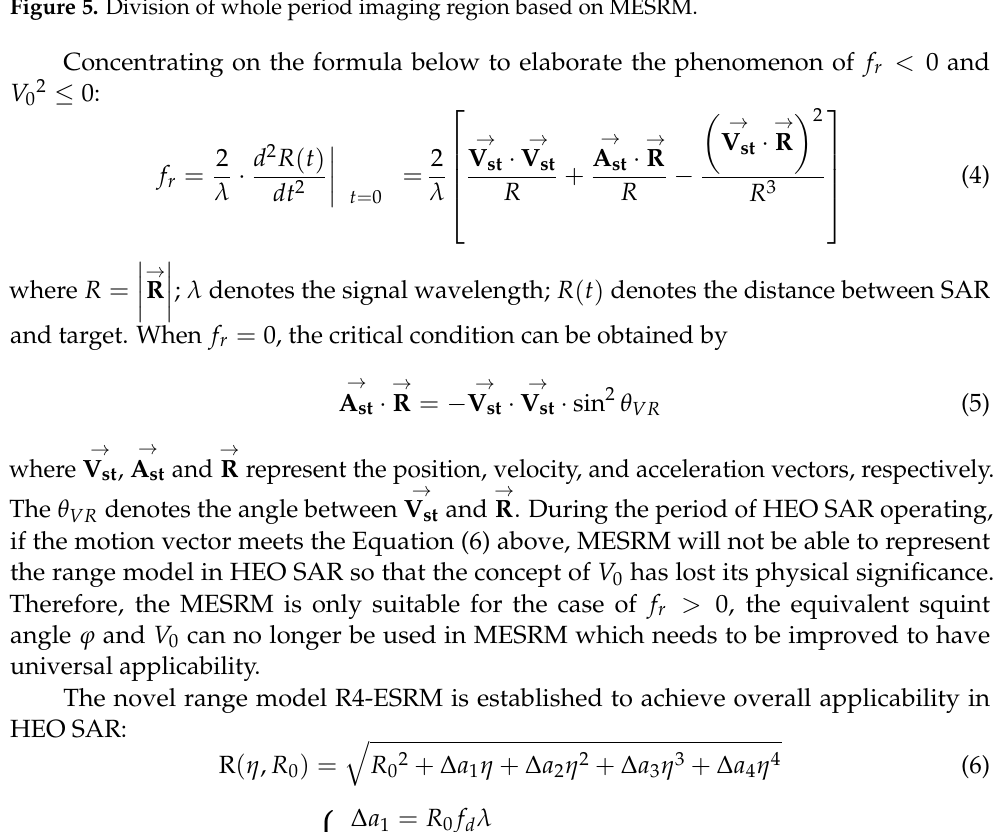
Figure 5. Division of whole period imaging region based on